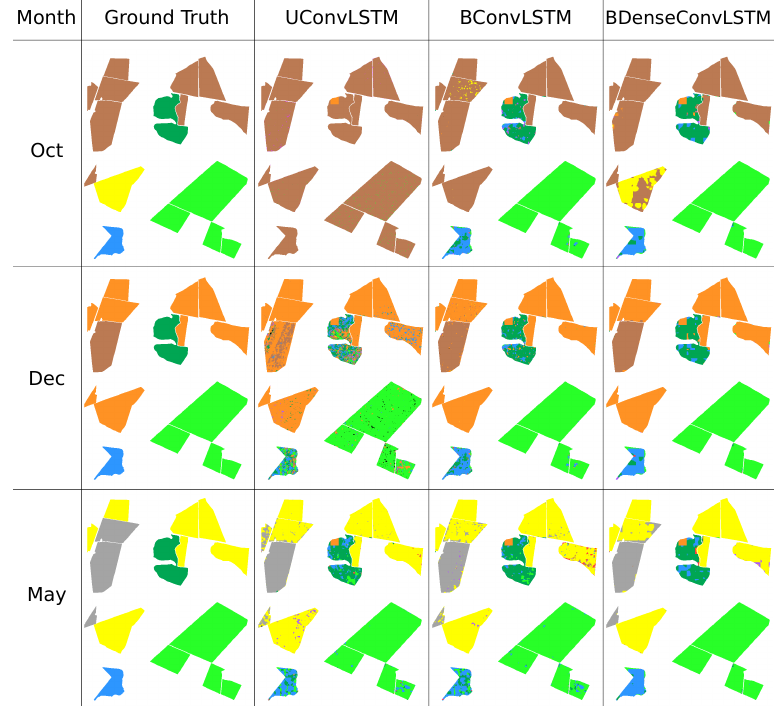
Figure 11. Sample structured output for Campo Verde study area.